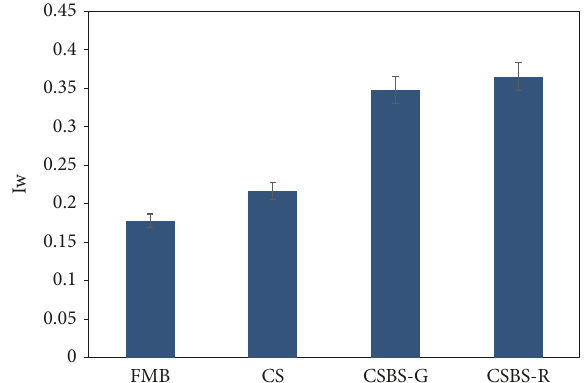
Figure 2: Amott water wettability index using formation brine (FMB), controlled salinity brine (CSB), controlled salinity water with greenzyme (CSBS-G), and controlled salinity water with rhamnolipids